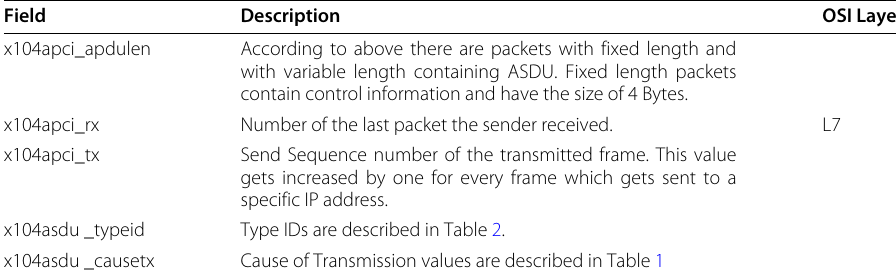
Table 6 Extracted features specific for x104 from Layer 7 Field